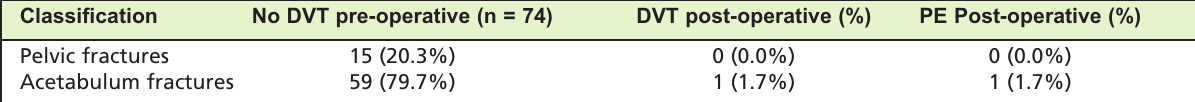
Proportion of patients negative for DVT preoperatively developing DVT and PE post-operatively Table IV: Classification